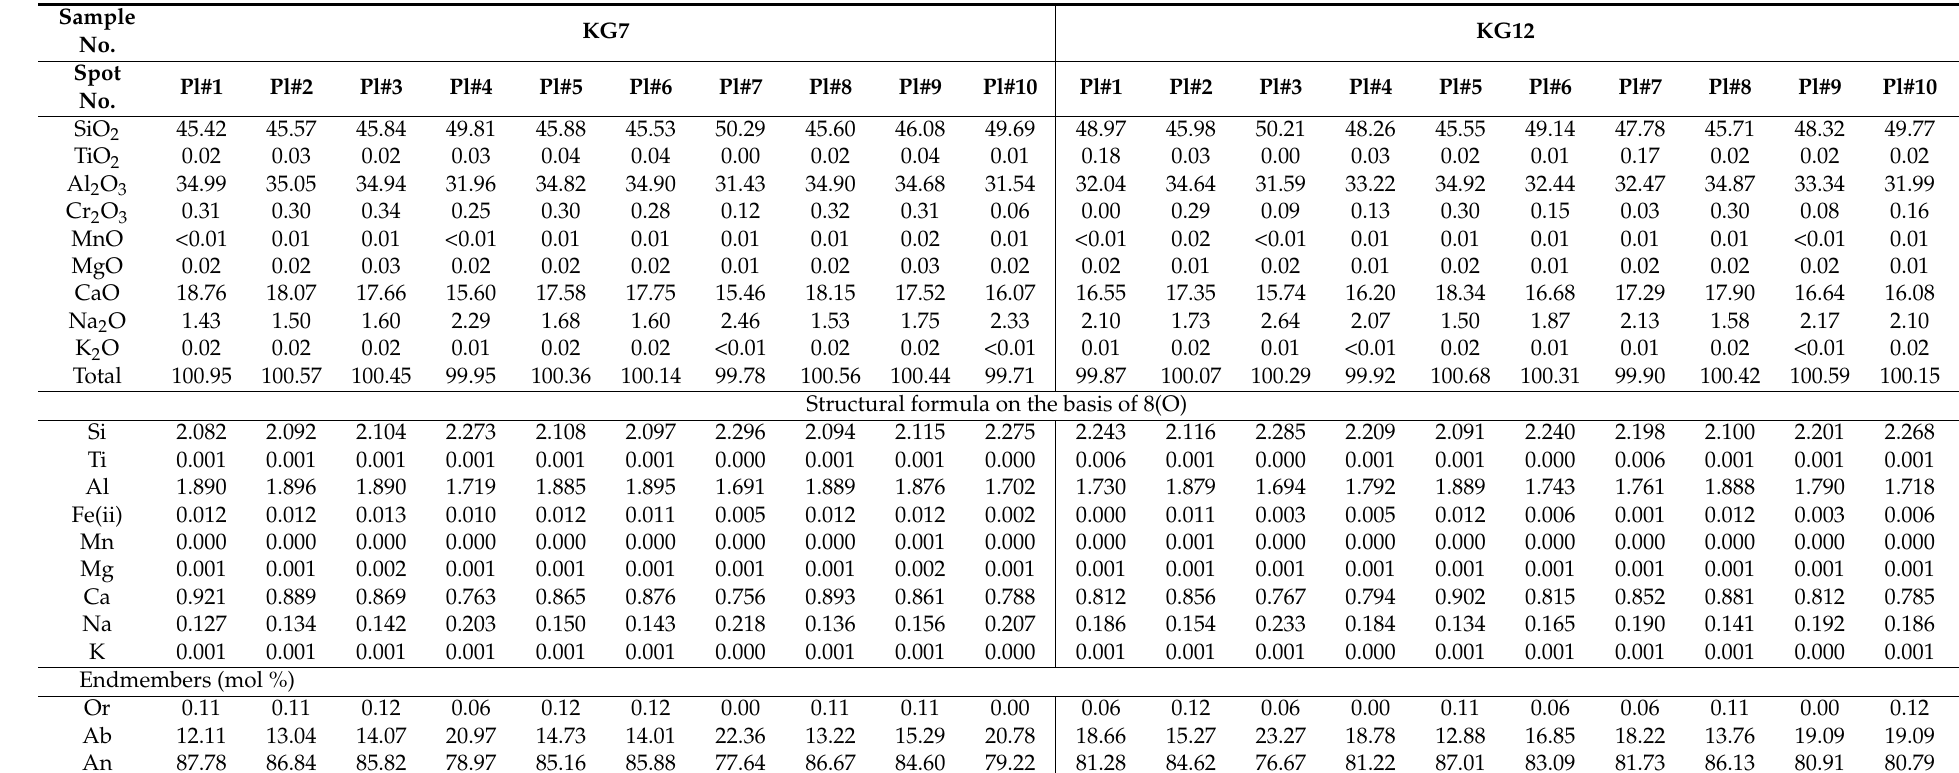
Table 3. Microprobe analyses of plagioclase in the olivine gabbro of the Khamal mafic